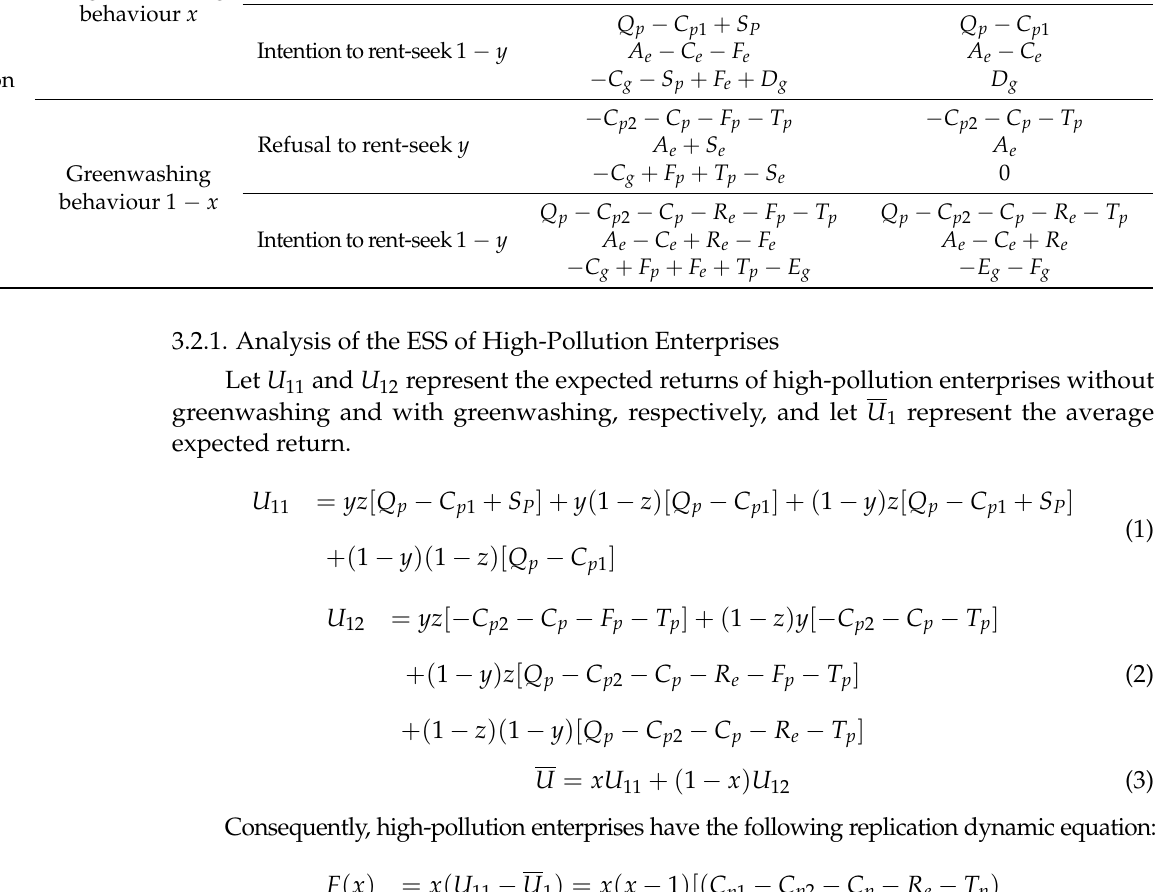
No greenwashing behaviour